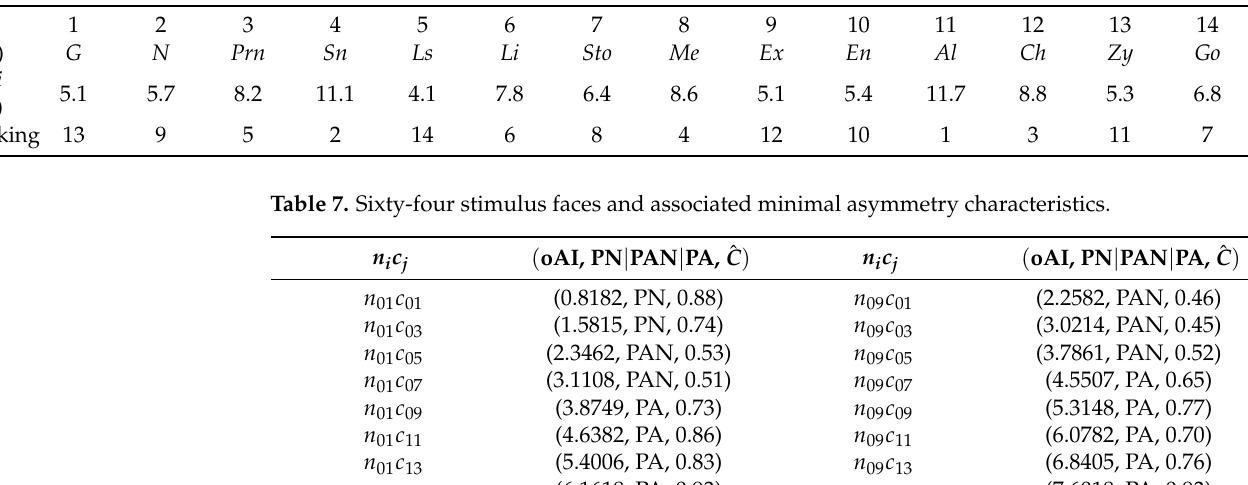
Table 6. Relative importance of the 14 facial features.